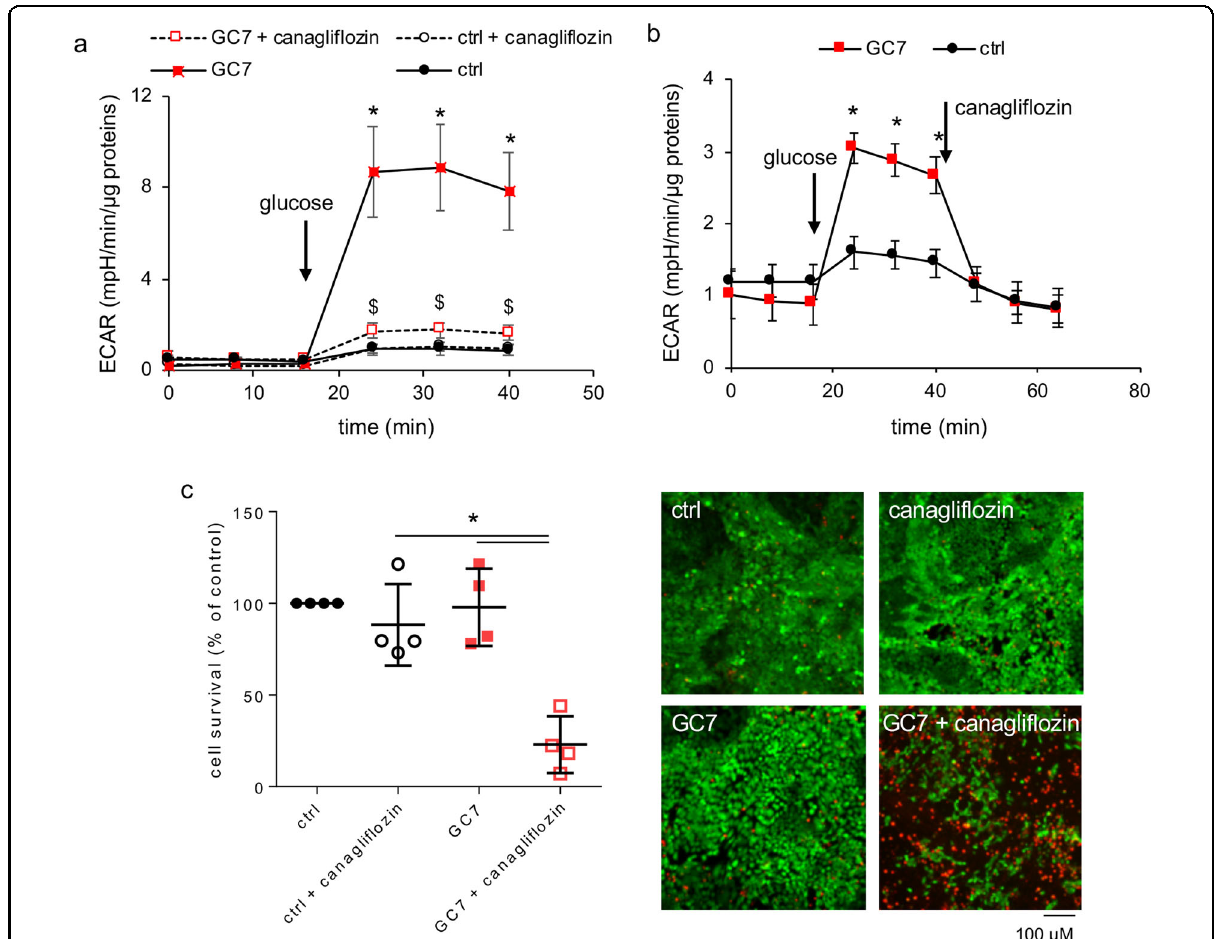
Fig. 3 SGLT2 glucose entry is essential to GC7-treated cell metabolism and survival. a , b Con fl uent PCT cells were treated or not with 30 µM GC7 for 24 h and then glycolysis in response to glucose addition (10 mM) was evaluated using Seahorse technology. Canagli fl ozin (10 µM) was added 4 h before analysis or along analysis as indicated. Dots displayed mean ± SD of three independent experiments. c Mortality evaluation using live/dead cells fl uorescence assay of PCT cells co-treated with 10 µM canagli fl ozin and 30 µM GC7. Representative pictures for each group are displayed and show live (green, calcein-FITC) and dead (red, ethidium bromide homodimer) cells. Scale bar is indicated. Graphic displayed scatter plot of four independent values and mean ± SD. * p < 0.05 evaluated using Kruskal – Wallis ( a , c ) or Mann – Whitney ( b )